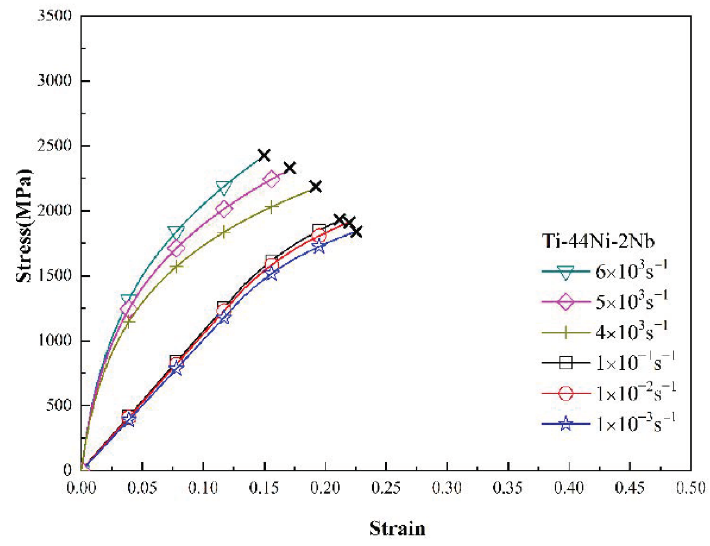
Figure 3. Low strain rate and high strain rate deformation curves of TiNi 44 Nb 2 alloy.